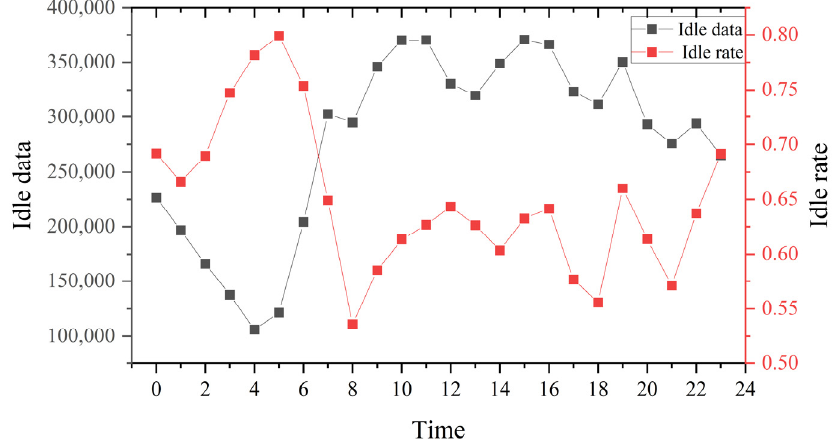
Figure 6. Taxis idling data volume and idling rate.